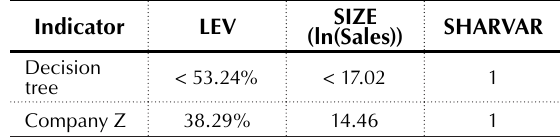
Table 6. Parameters of company Z compared